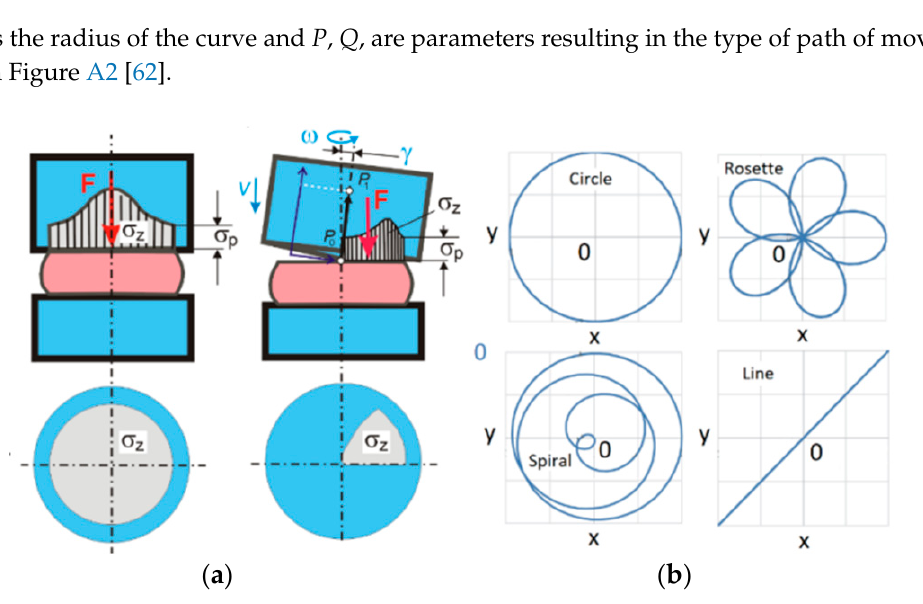
Figure A2. ( a ) Comparison of classical and orbital forging, where F is the process force, σ z is the axial stress, σ p is the yield stress, and γ is the tilt angle; and ( b ) Movements obtainable in accordance with Equation (A5).